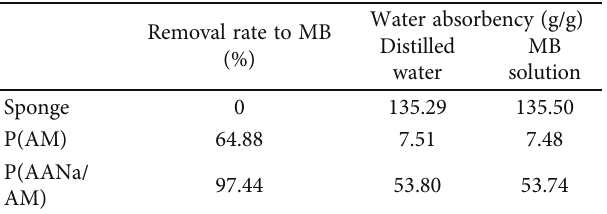
Table 1: Comparison of the MB removal rate and water absorbency for sponge, P(AM), and